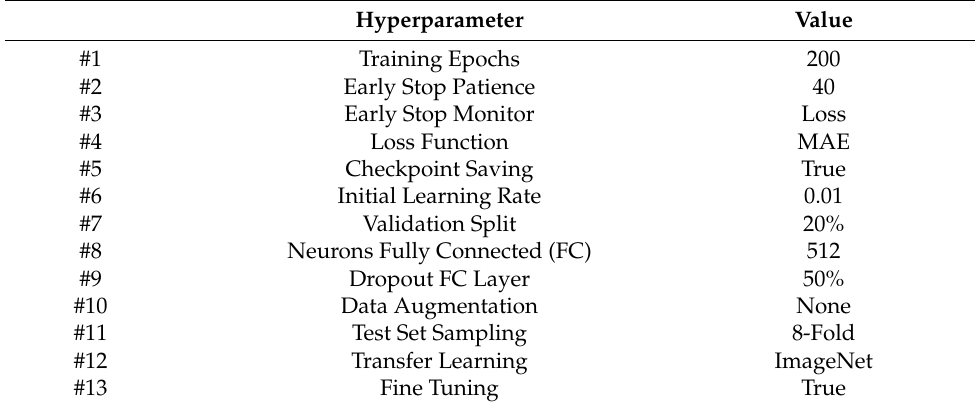
Table 2. Hyperparameter values used (common to all architectures).